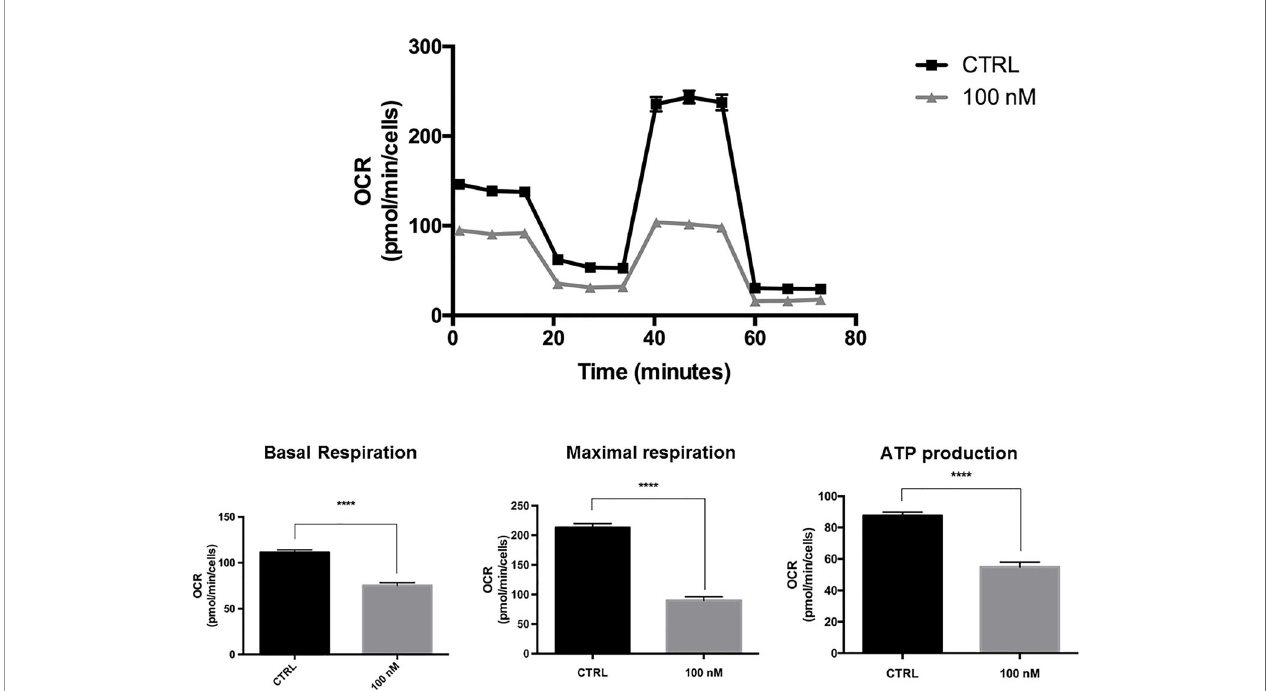
FIGURE 6 | MTDR potently inhibits the mitochondrial OCR in a CSC-enriched MCF7 cell population. A representative Seahorse tracing is shown, with bar graphs highlighting the quantitative effects of MTDR on basal respiration, maximal respiration and ATP production. Note that MTDR treatment exhibits inhibition of OCR at 100 nM. Brie fl y, MCF7 cells were seeded for 3D-mammosphere formation and were grown for 5-days using the standard protocol, but in the absence or presence of MTDR at a lower concentration (100 nM), to avoid cell death. Then, the resulting 3D-mammospheres were collected, dissociated into single cells and subjected to OCR analysis. Under these conditions, mitochondrial ATP production was reduced by nearly 50%. The statistical test used was a one-tail unpaired 3D propagation CSCs from all three cancer cell lines, using nano-